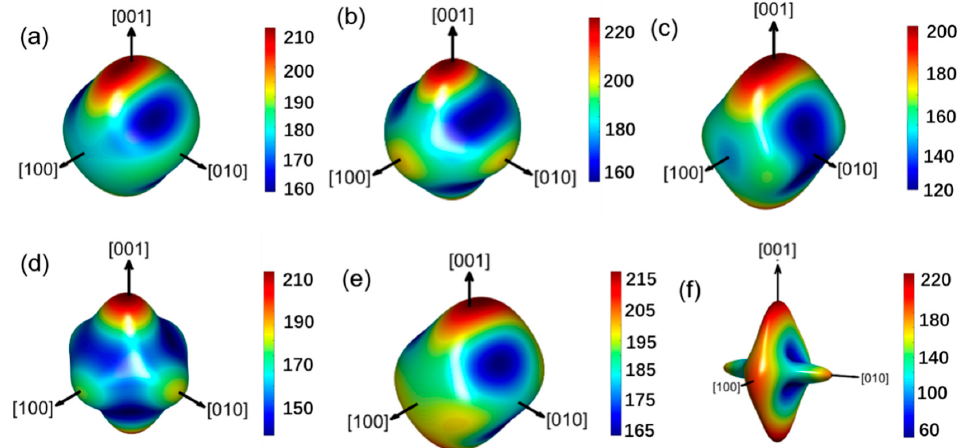
Figure 7. Young’s modulus 3D surface of Al 13 (Fe,M) 4 phases with different elements doping (unit: GPa). ( a ) Al 13 Fe 4 , ( b ) Al 13 (Fe,Co) 4 , ( c ) Al 13 (Fe,Cu) 4 , ( d ) Al 13 (Fe,Cr) 4 , ( e ) Al 13 (Fe,Mn) 4 , ( f ) Al 13 (Fe,Ni) 4 .